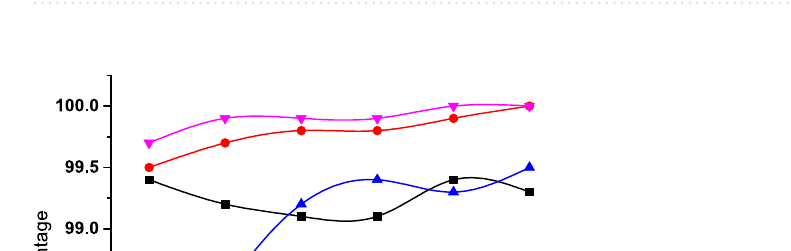
Table 1. Simulation environment.